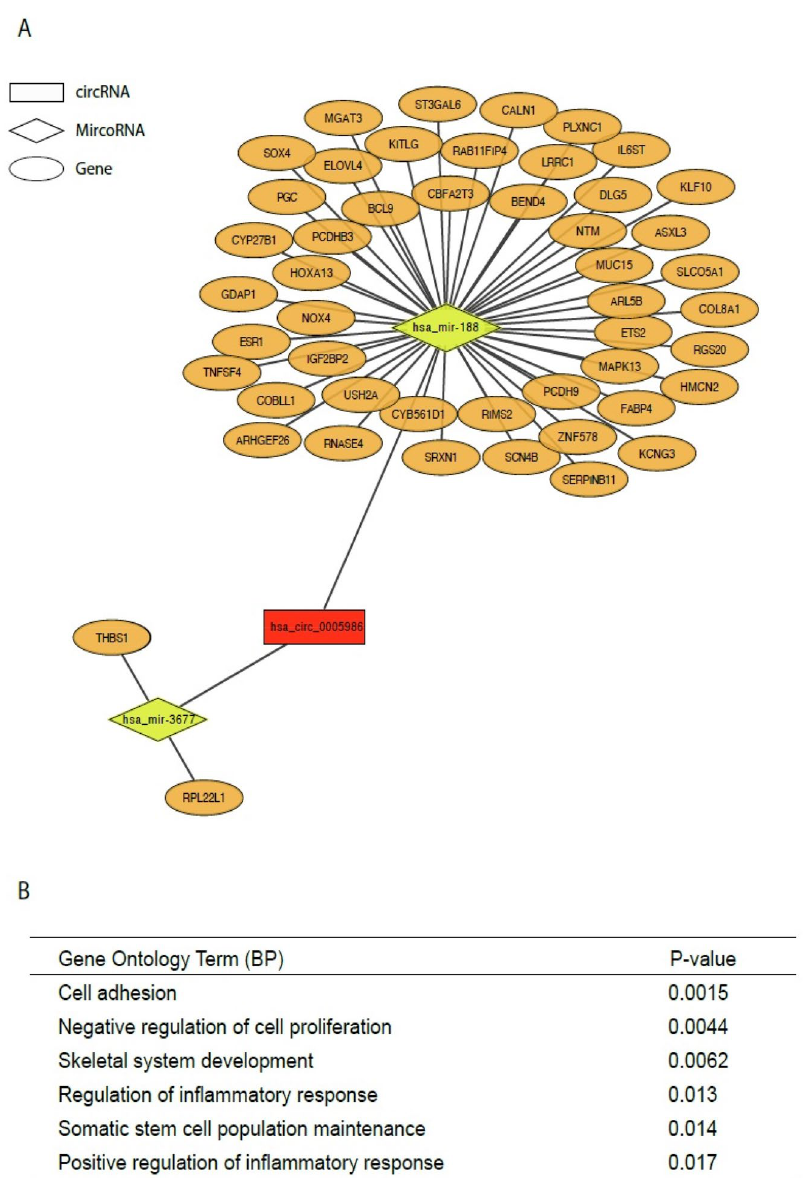
Figure 5. Construction of circRNA–miRNA–mRNA network. ( A ) An Illustration of circRNA-miRNA-mRNA interaction network ( B ) gene ontology analysis of target genes. BP biological